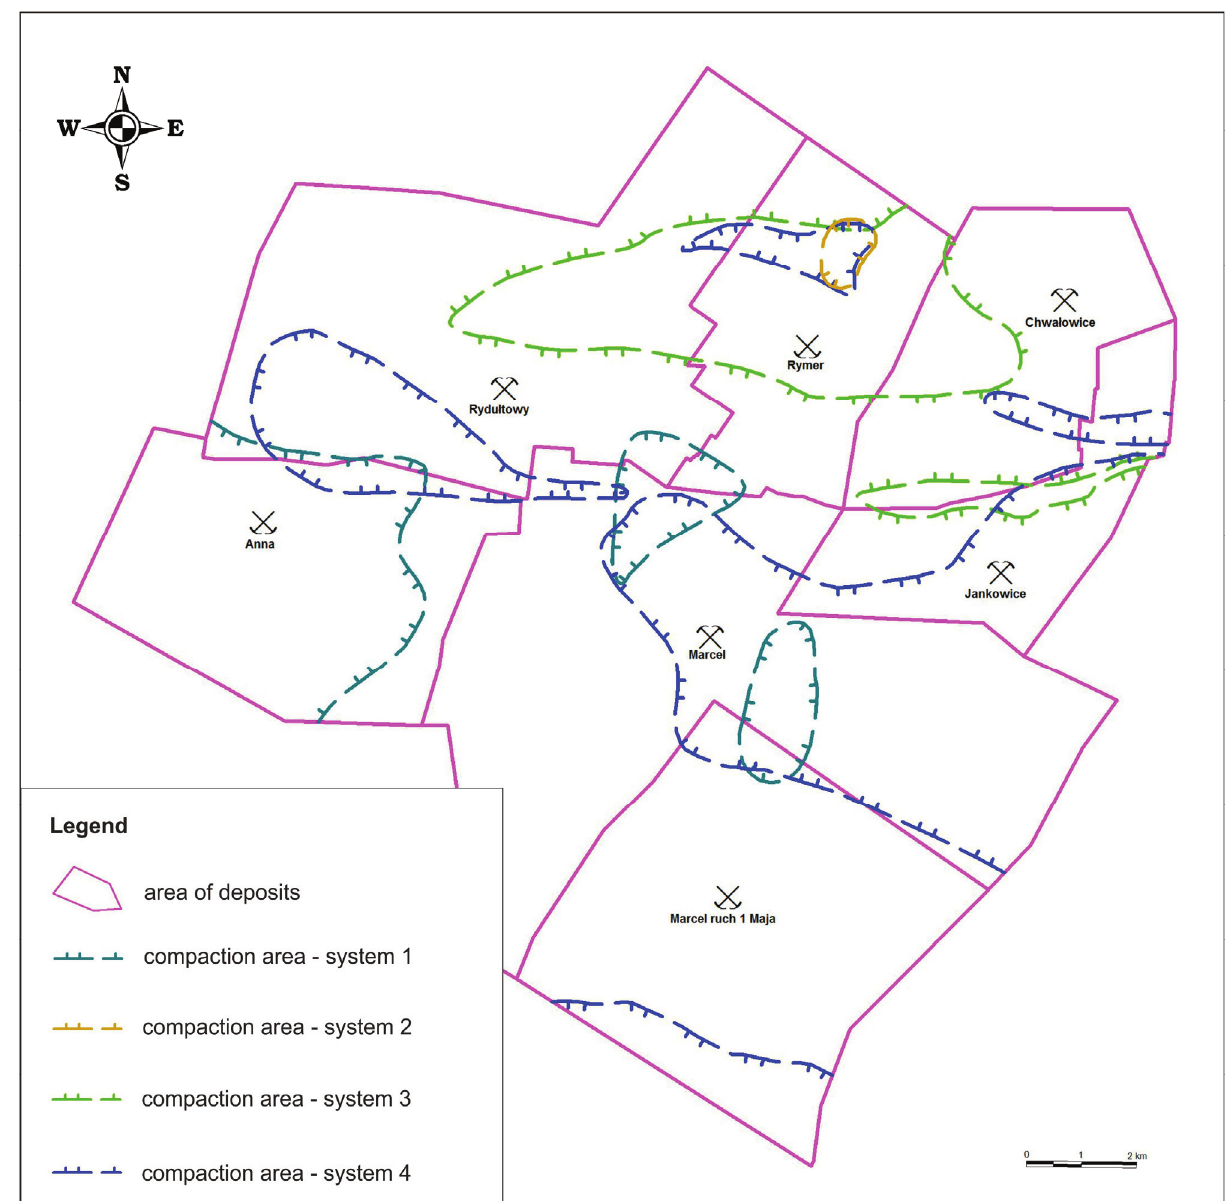
Fig. 5. The compaction areas for the four tectonic fault